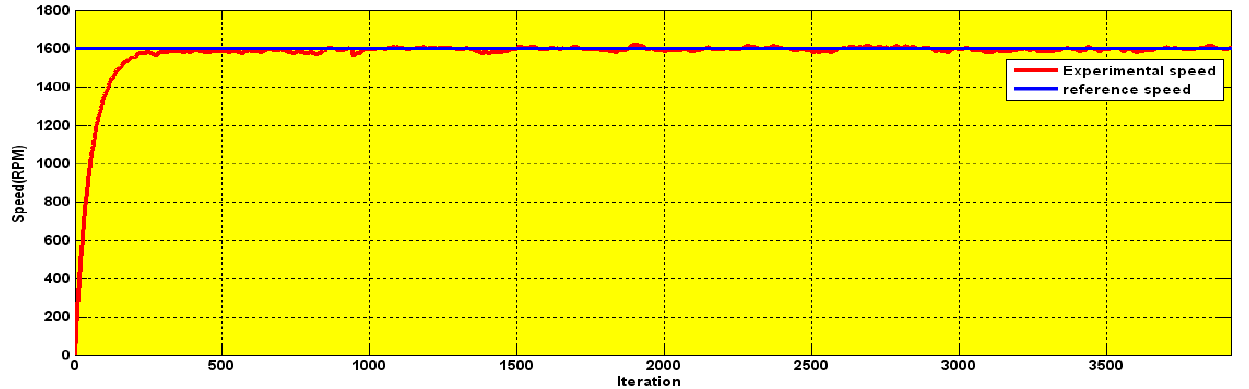
Figure 7. Experimental results of the speed tracking by the